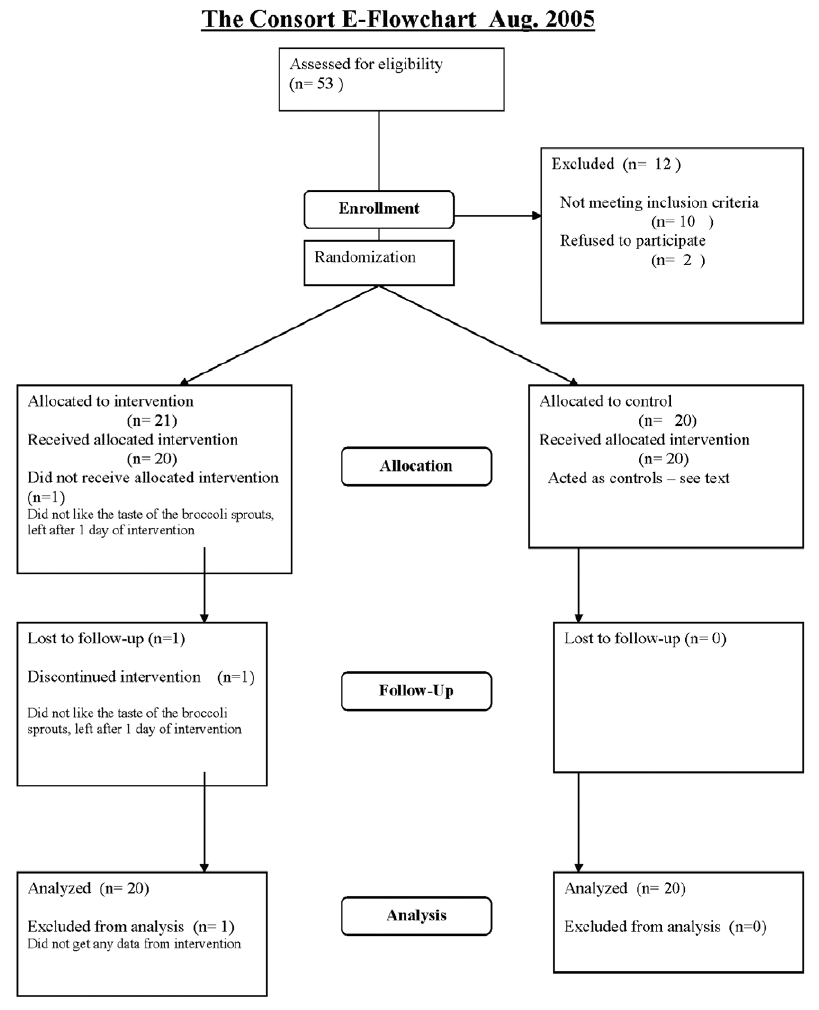
Figure 1. Consort 2001 flow diagram.